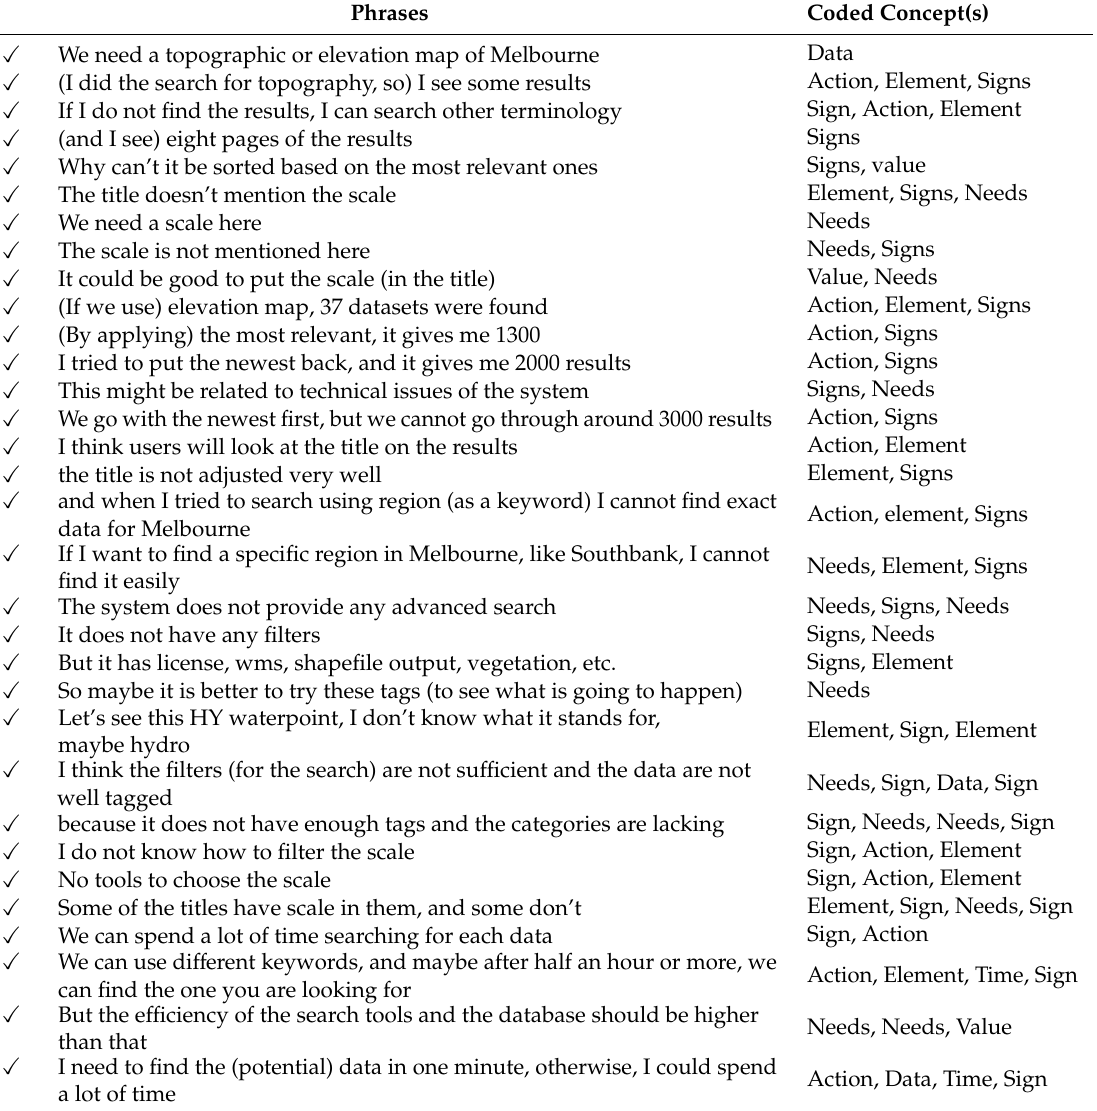
Table 2. Example of Referring Phrase Analysis (RPA) results from TAP for spatial metadata usability